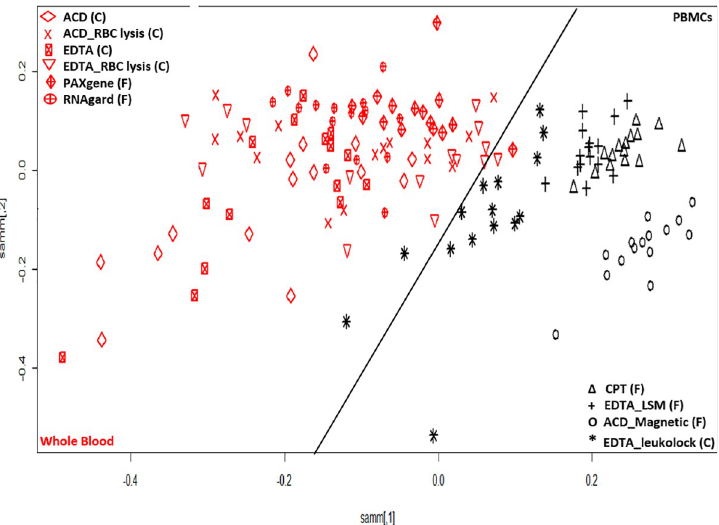
Fig 3. Two dimensional Sammon projection using the top 50% of most variable transcripts (25370) for whole blood (red) and PBMC (black). There is a clear distinction in clusters for PBMCs and whole blood sample processing as marked by a black tilted line. All whole blood samples are shown on left side and PBMC samples are on the right side of the plot. The (F) and (C) denotes the frozen and cold conditions for the sample collection and storage. The description of all the legends is given here. PBMCs samples: ACD_Magnetic - blood collected in ACD-A tubes and separated using magnetic method followed by extraction using TRIzol 1 method. CPT —blood collected in CPT tubes and PBMCs separation using manufacturer recommendations followed by extraction using TRIzol 1